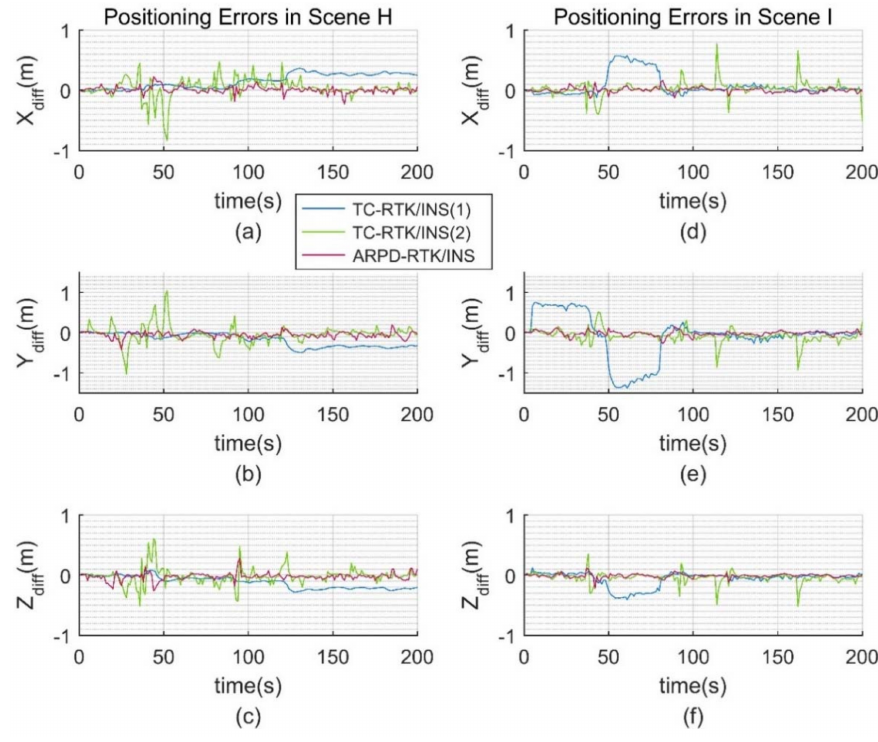
Figure 18. ( a ) Error distribution in the ECEF-X axis for Scene H; ( b ) Error distribution in the ECEF-Y axis for Scene H; ( c ) Error distribution in the ECEF-Z axis for Scene H; ( d ) Error distribution in the ECEF-X axis for Scene I; ( e ) Error distribution in the ECEF-Y axis for Scene I; ( f ) Error distribution in the ECEF-Z axis for Scene I. Table 5. Trajectory error and fix rate for different RTK algorithms on the real dataset (unit: m). Algorithm